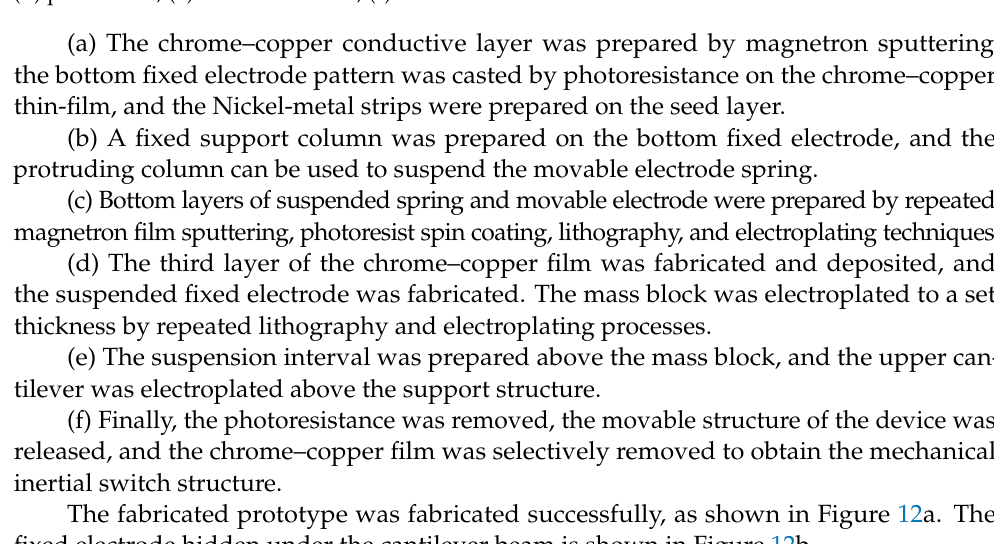
Figure 12. The photos of prototype. ( a ) the complete structure drawing of fabricated inertial switch, ( b ) the elastic fixed electrode.